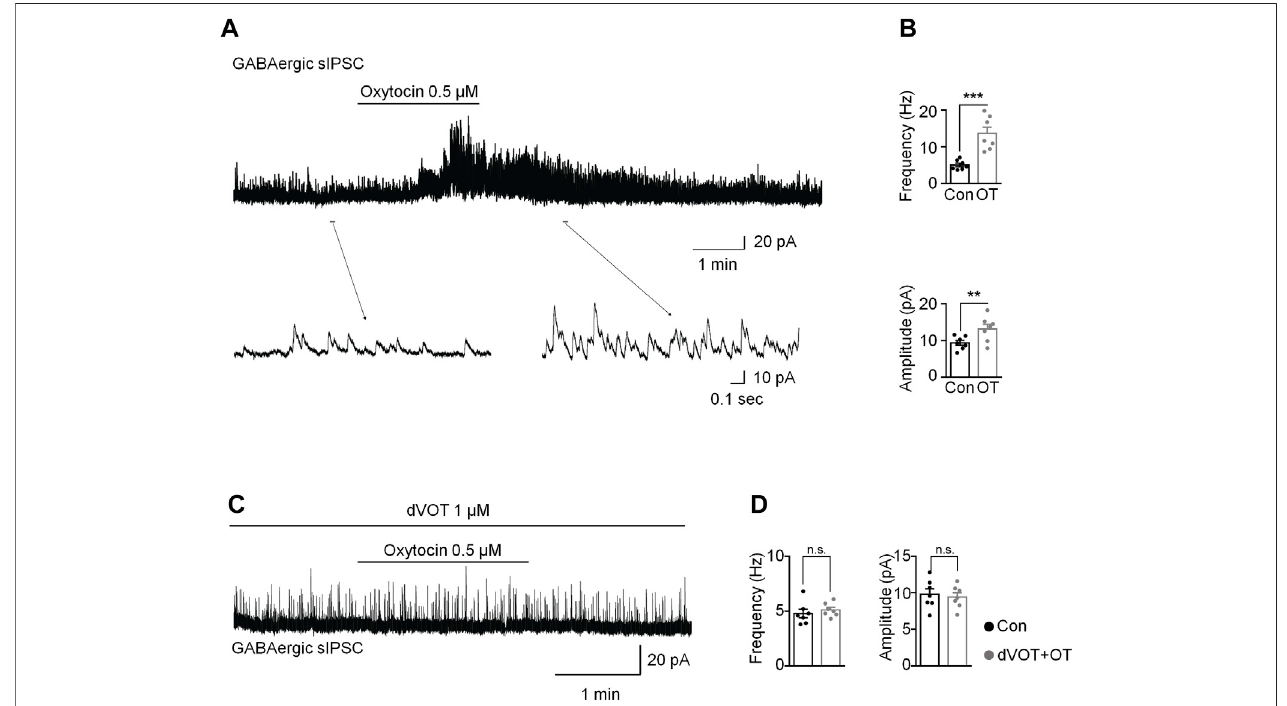
FIGURE7| OTenhancedGABAergicinhibitorytransmissionthroughactivationofOXTRsinthesuper fi cialdorsalhorn. (A,B) OTperfusionincreasedthefrequency andamplitudeofspontaneousGABAergicIPSCs. (C,D) TheselectiveOxtrantagonistdVOTblockedOT-enhancedGABAergicspontaneoustransmission.Paired t -test. Data are expressed as mean ± SEM. ** p < 0.01, *** p < 0.001 vs.